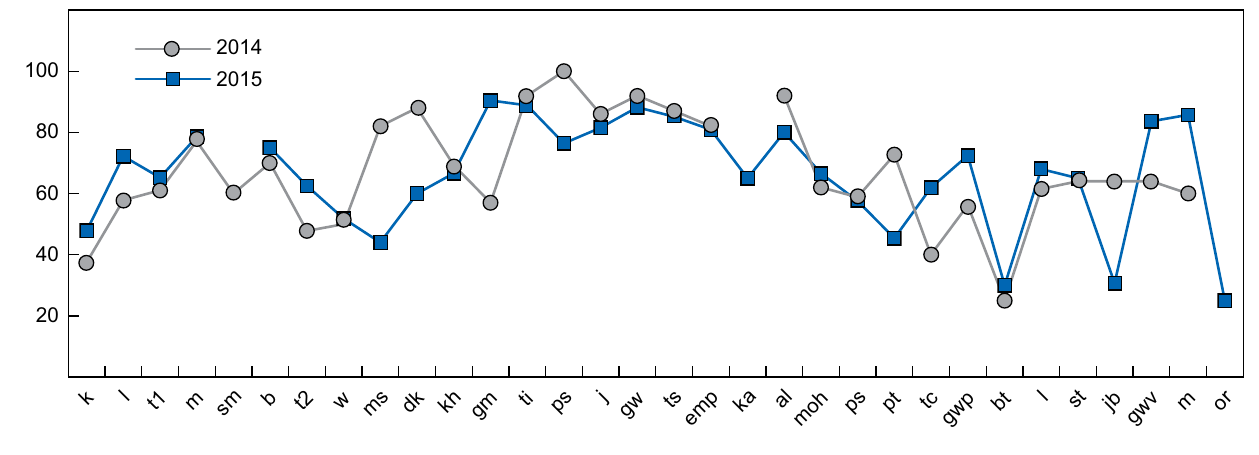
Figure 9: Virological suppression between clinics